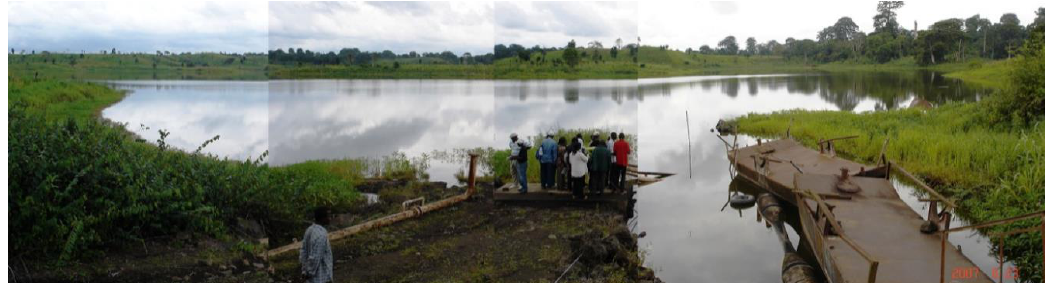
Figure 17. Lake Mamy Water with water rich in phosphorus. It is pumped by the plantations of Upper Penja (PHP) to water the banana, pineapple and papaw plantations, etc. (Source: Tchindjang, August 2007).